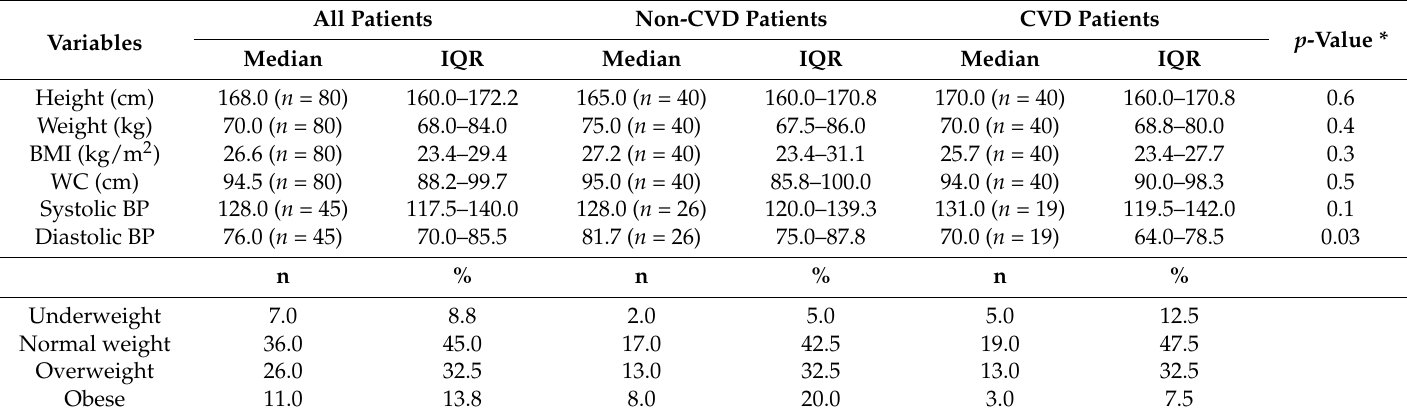
Table 4. Anthropometric measurements of the study